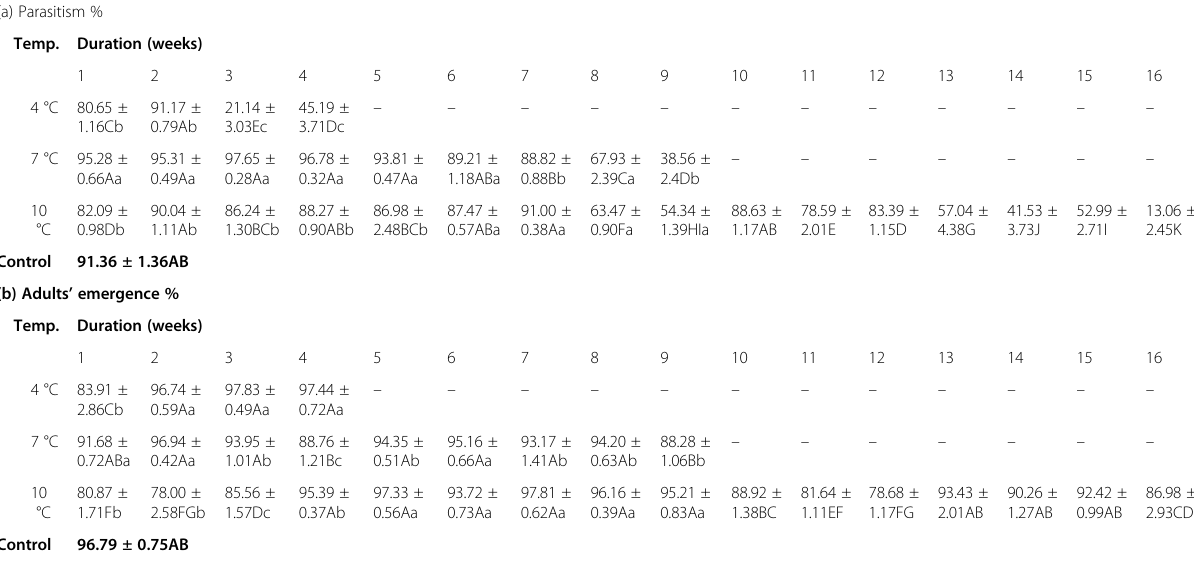
Means ± SE sharing the same capital letters in the same row, and same small letters in the columns are statistically insignificant ( P ≥ 0.05)